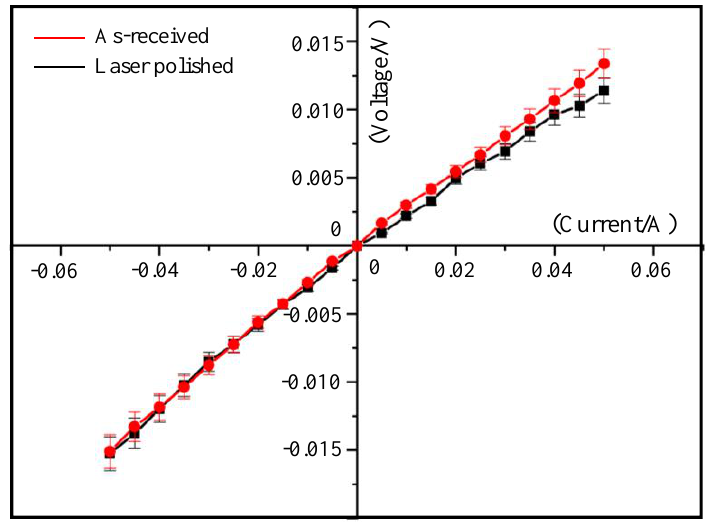
Figure 7. Comparison of I-V characteristic curves of as-received and laser-grinded surfaces at the single-crystal silicon wafer.